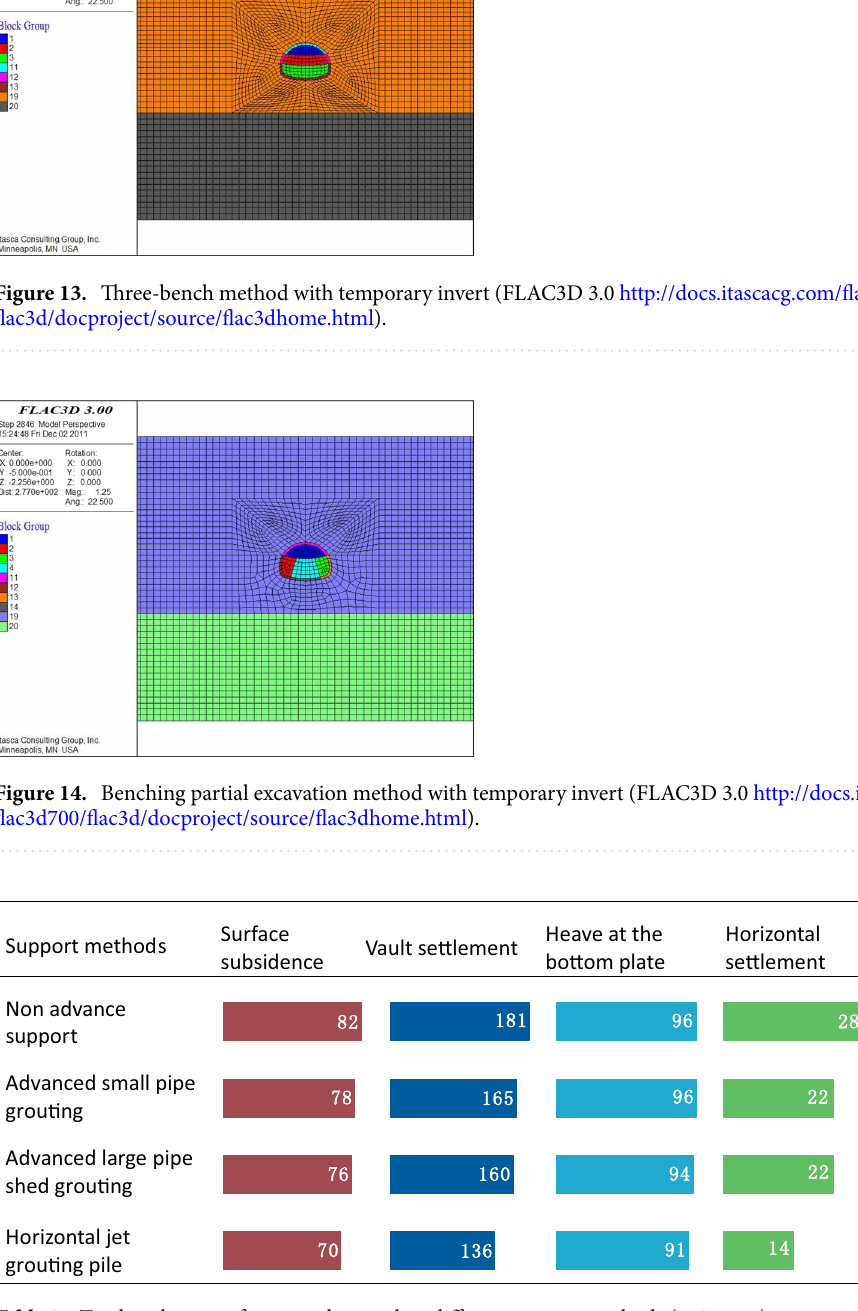
Table 8. Total settlement of surrounding rock at different support methods (unit: